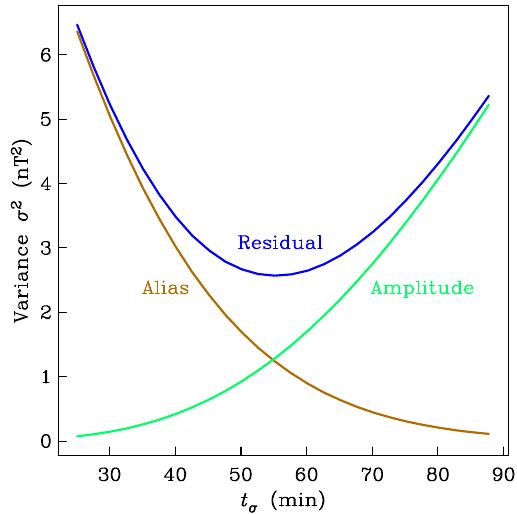
Fig. 4. Trade-off diagram, for CLF- H 1998.0–2009.0, showing variance of amplitude distortion A σ s (t) (green), aliasing S σ s (t) (brown), and low-frequency residuals L σ s (f ) (blue) for Gaussian average-samples over a range of averaging times t σ .